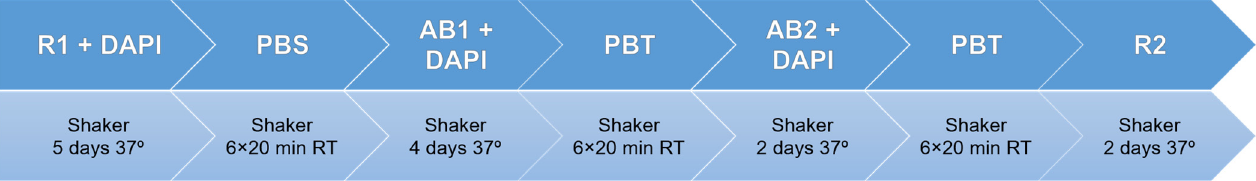
Figure 2. CUBIC clearing and IHC staining protocol for melanoma xenograft model samples.